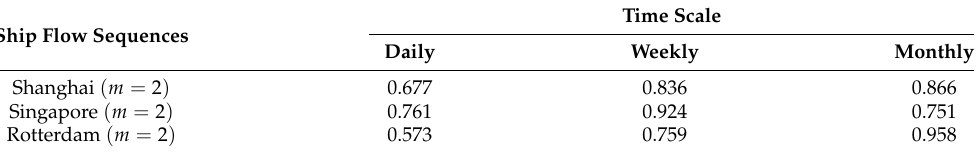
Table 3. Generalized Hurst exponents ( q = 2 ) for ship flow sequences with different time